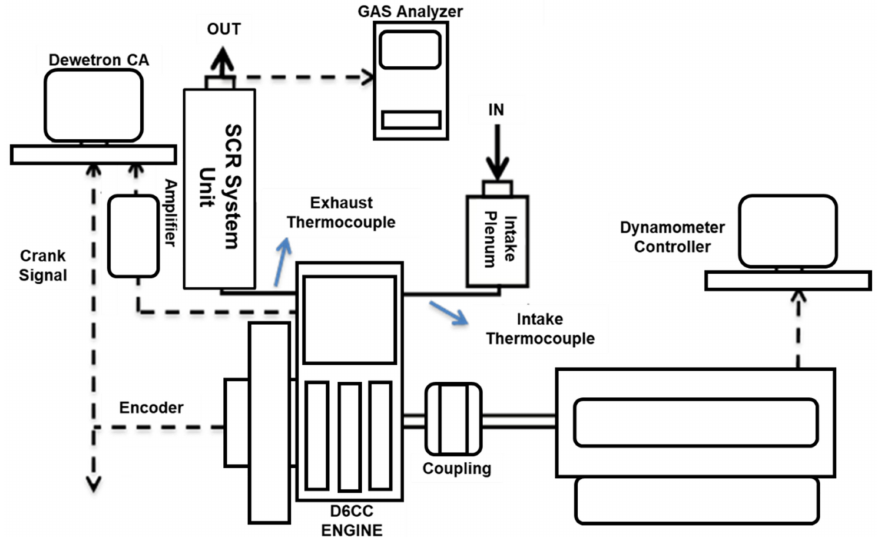
Figure 30. Schematic diagram of the engine test adapted from Khristamto et al.